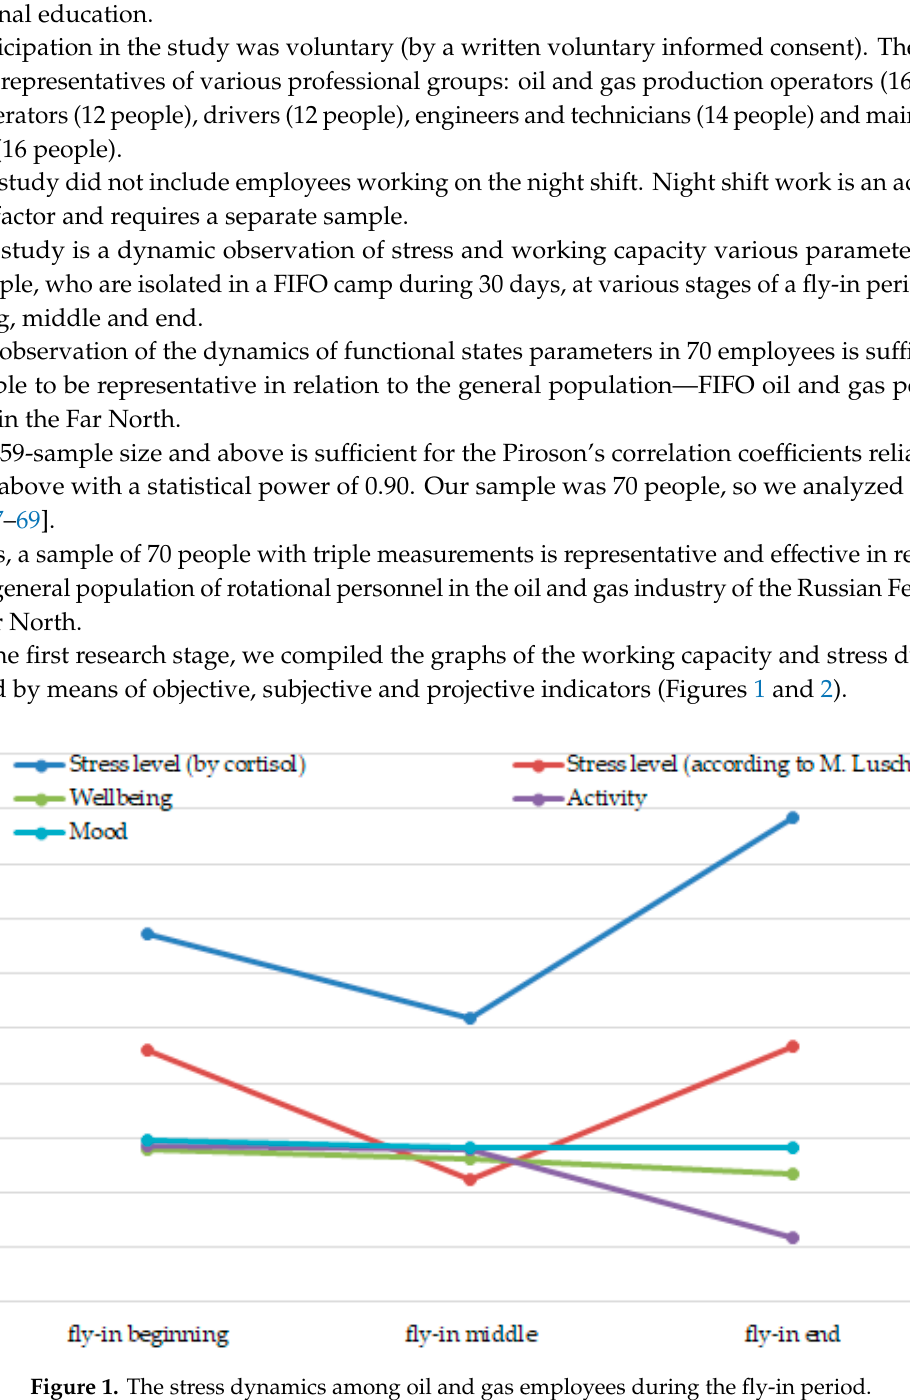
Figure 1. The stress dynamics among oil and gas employees during the fly-in period.